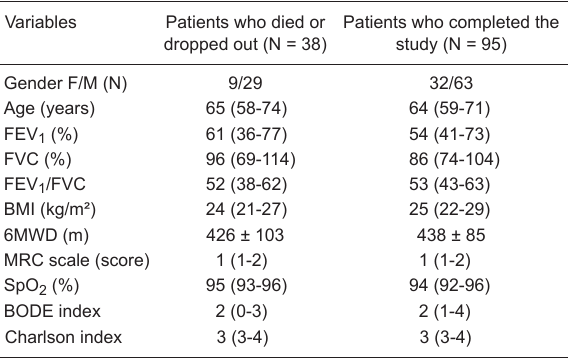
Table 2. Comparison of the characteristics of patients who died or dropped out versus those who completed the study.